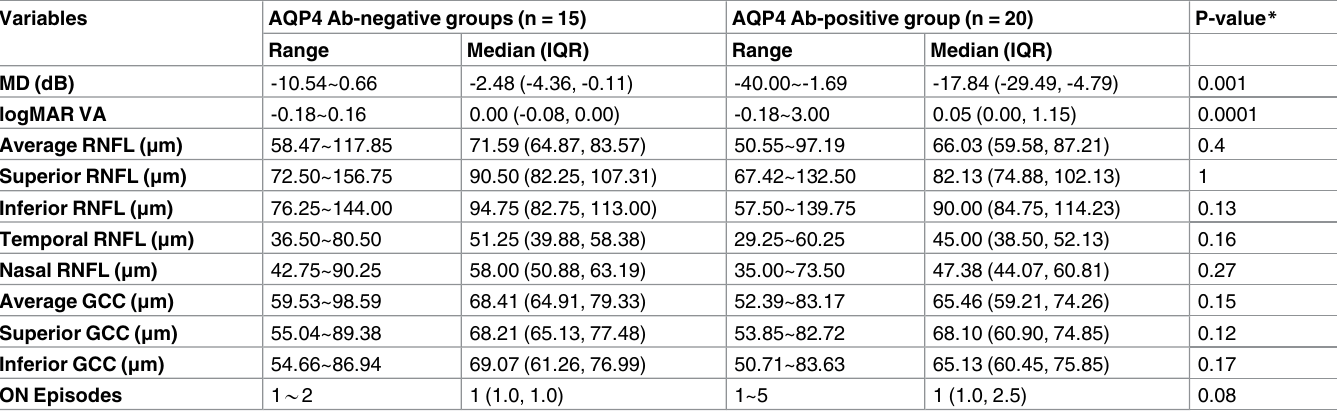
Table 2. Eye-based